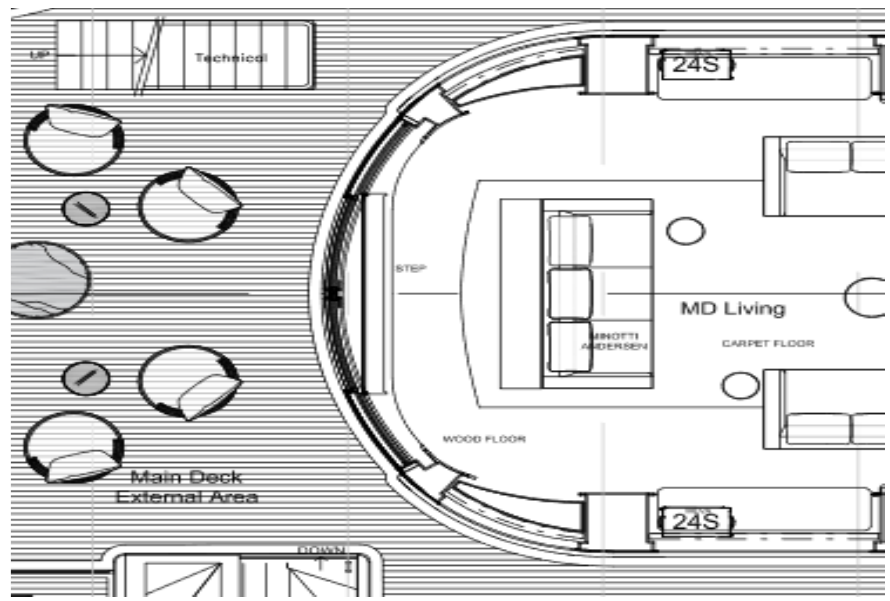
Figure 1. LD layout under analysis.